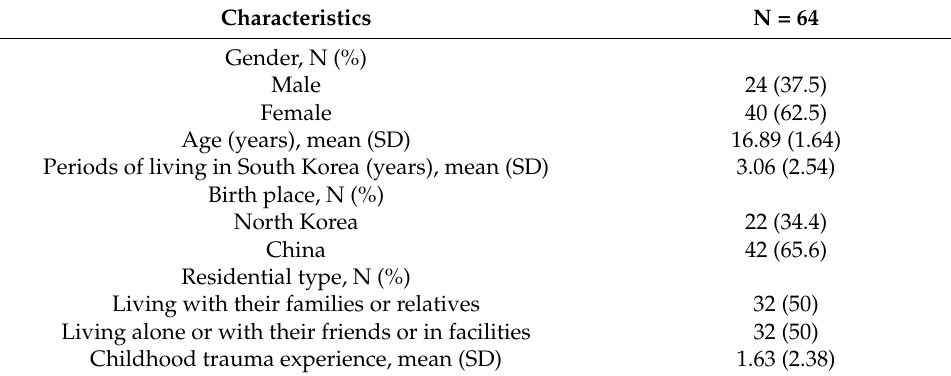
Table 1. Characteristics of participants at the baseline point.